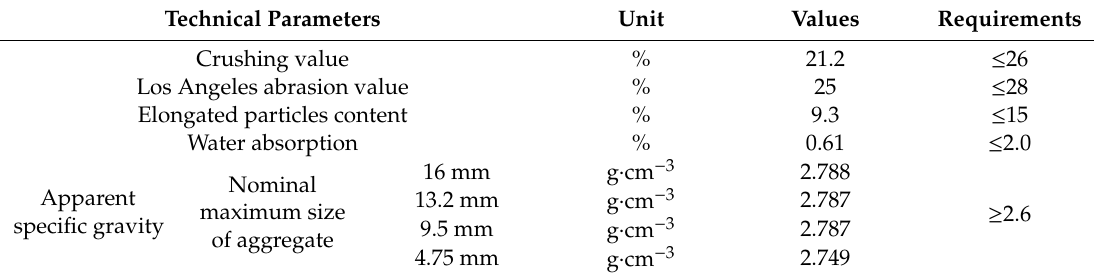
Table 2. Technical parameters of coarse